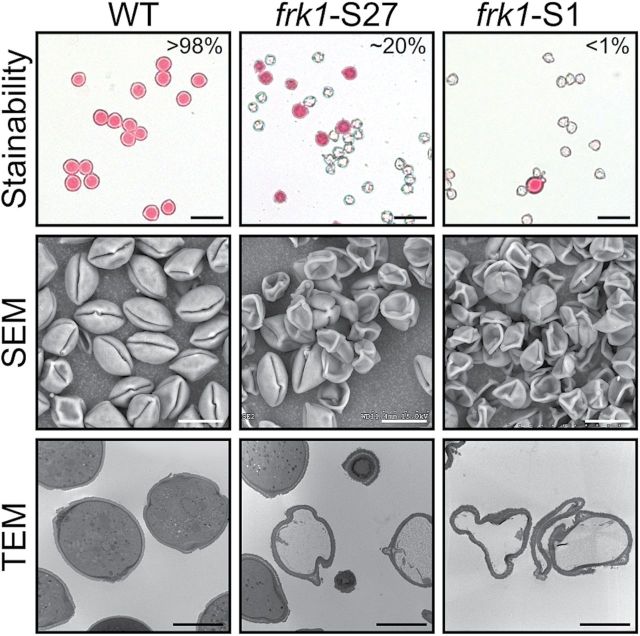
Pollen viability estimation in WT and two ScFRK1 transgenic plant lines. Pollen viability and phenotype were estimated through viable stain analysis and electron microscopy observations. Upper panels: pollen was stained with 1% acetocarmine. Viable pollen grains are lightly stained in pink, while dead pollen cells are shown as empty and shrivellled shells. Scale bar=50 μm. Middle panels: examination of fresh pollen outer structure through scanning electron microscopy (SEM) analysis under low vacuum conditions. Affected mutants lines produced shrivelled and collapsed pollen grains. Scale bar=20 μm. Lower panels: transmission electron microscopy (TEM) of pollen sections revealed that the collapsed or shrivelled pollen grains are devoid of cytoplasm and organelles. Scale bar=10 μm.